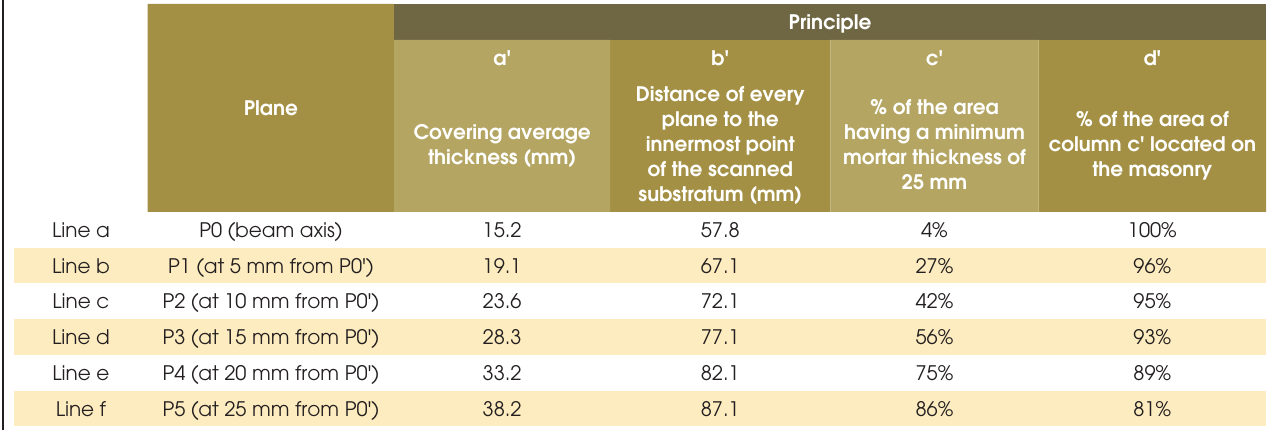
Table 3 – Brief results of planes traced from the 1 st reference plane in relation to the scanned image